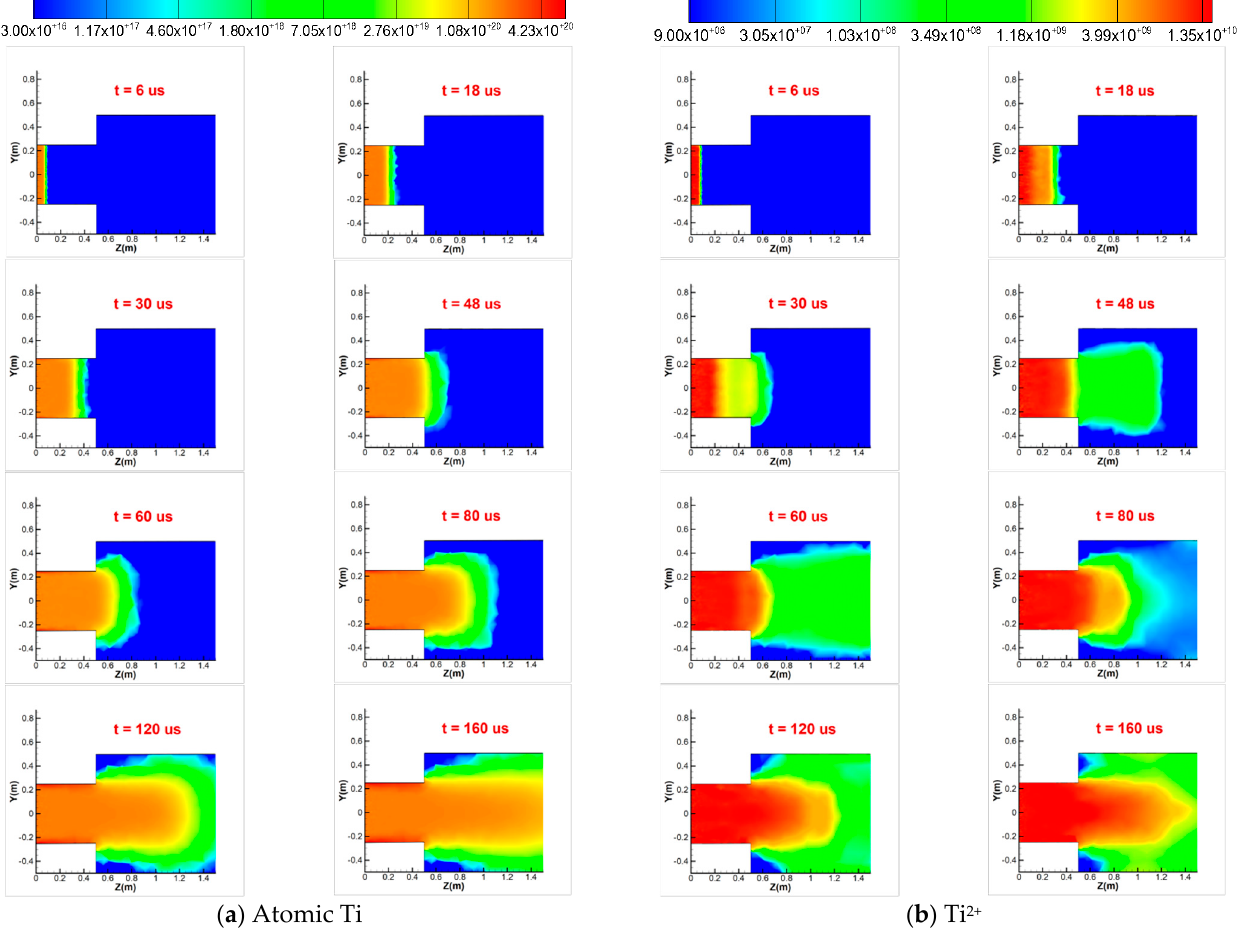
Figure 4. Number density distributions of atomic Ti and Ti 2+ at different times on the x = 0 plane.